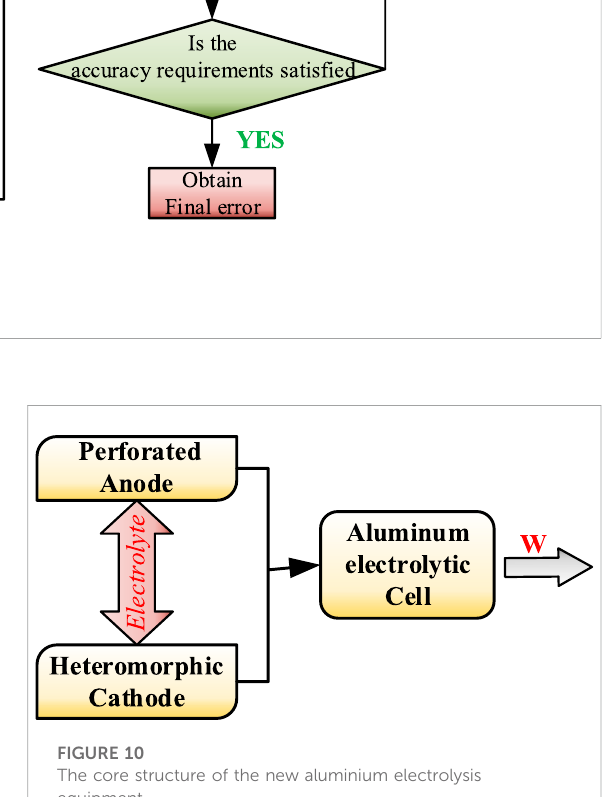
FIGURE 10 The core structure of the new aluminium electrolysis